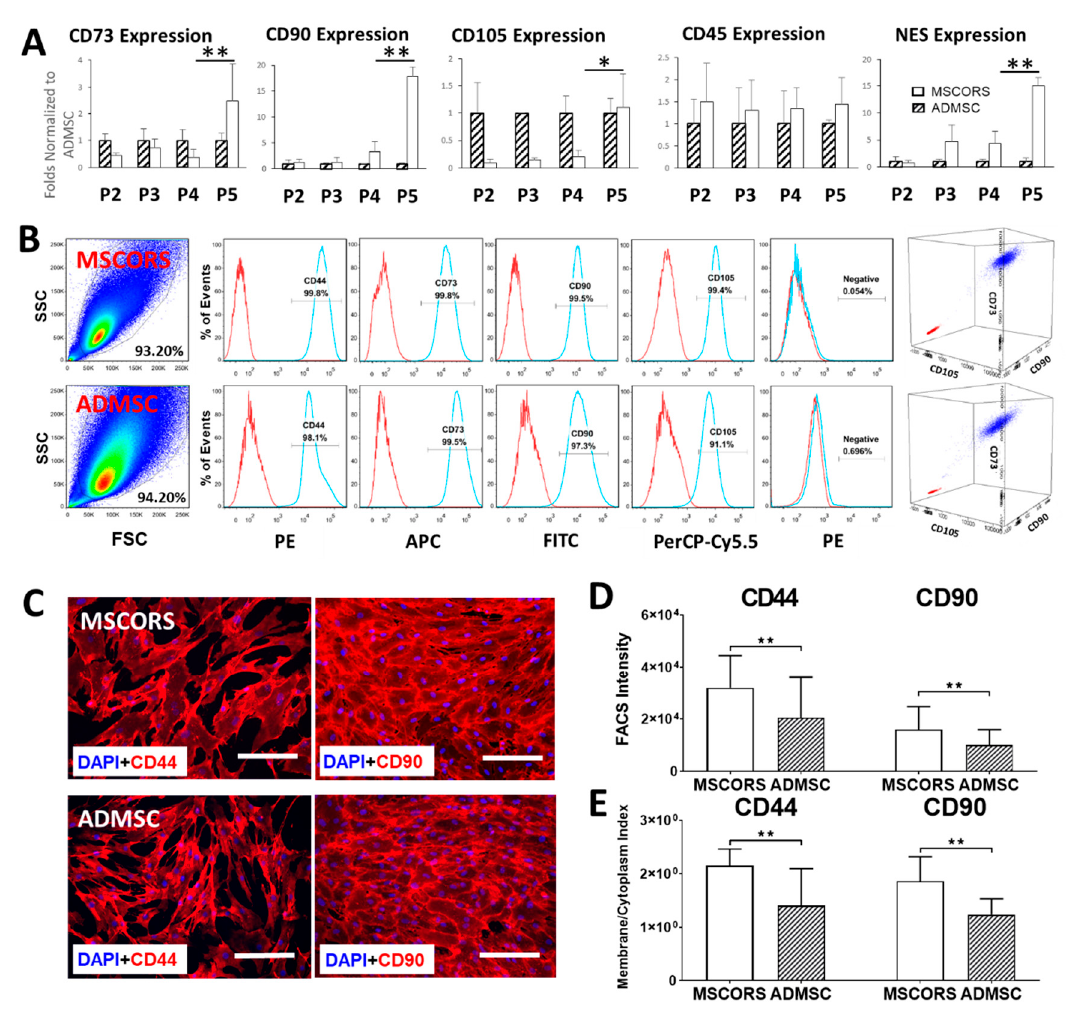
Figure 2. Phenotype of MSCORS compared with ADMSC. ( A ): qRT-PCR showing the relative gene expression of CD73 , CD90 , CD105 , CD45 , and NES of MSCORS against ADMSC from passage 2 to passage 5 ( n = 5). HTRP-1 was used as the internal reference. ( B ): Flow cytometer analysis of surface marker expression on MSCORS and ADMSC. Cells from passage 3 to 5 were labeled with antibodies against human antigens CD44, CD73, CD90, CD105, and MSC-negative marker combination (CD45 / CD34 / CD11b / CD19 / HLA-DR). Representative plot graphs and histograms are shown with antibodies (blue) and isotype control (red). ( C ): Expression of CD44 and CD90 in MSCORS and ADMSC ( n = 5). CD44 and CD90 display varied overall intensity and di ff erent subcellular distribution. ( D ) Expression of CD44 and CD90 analyzed from FACS signal intensity. ( E ) Membrane / cytoplasm index of CD44 and CD90 expression intensity in MSCORS and ADMSC. Data are shown as mean ± SD (* p < 0.05, ** p < 0.01) ( n = 5). Scale bar corresponds to 200 µ m; magnification ( C ) 10 ×.